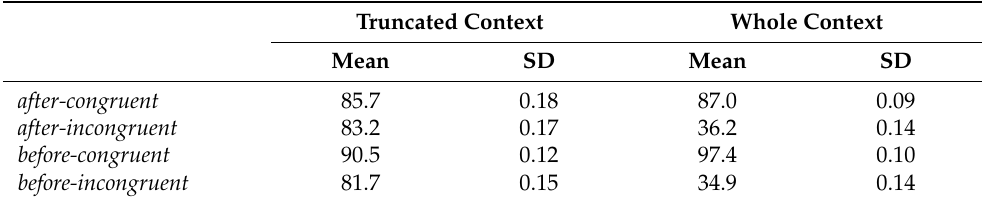
Table 4. Mean percentage of the closer referents chosen for the locative pronoun nali for each condition in forced choice